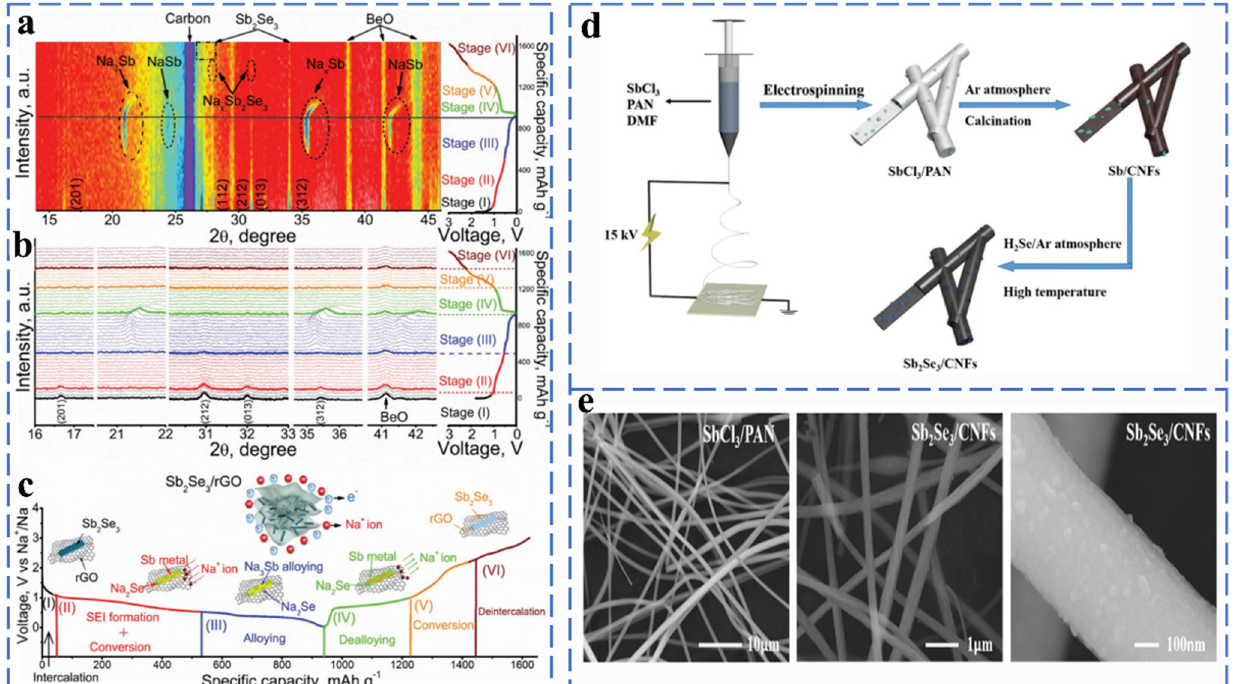
Figure 6. ( a ) In situ XRD patterns of Sb 2 Se 3 /rGO anode operated at different states of charge against the voltage during the initial cycle. ( b ) XRD patterns within a selected 2 θ range during the first cycle against the voltage. ( c ) Schematic of the reaction mechanism of the Sb 2 Se 3 /rGO hybrid during the charge/discharge process. Reprinted with permission from Ref. [53]. Copyright 2019, copyright Hou, M. ( d ) Schematic illustration of the fabrication process of Sb 2 Se 3 /CNFs. ( e ) SEM image. Reprinted with permission from Ref. [54]. Copyright 2021copyright Luo, F.